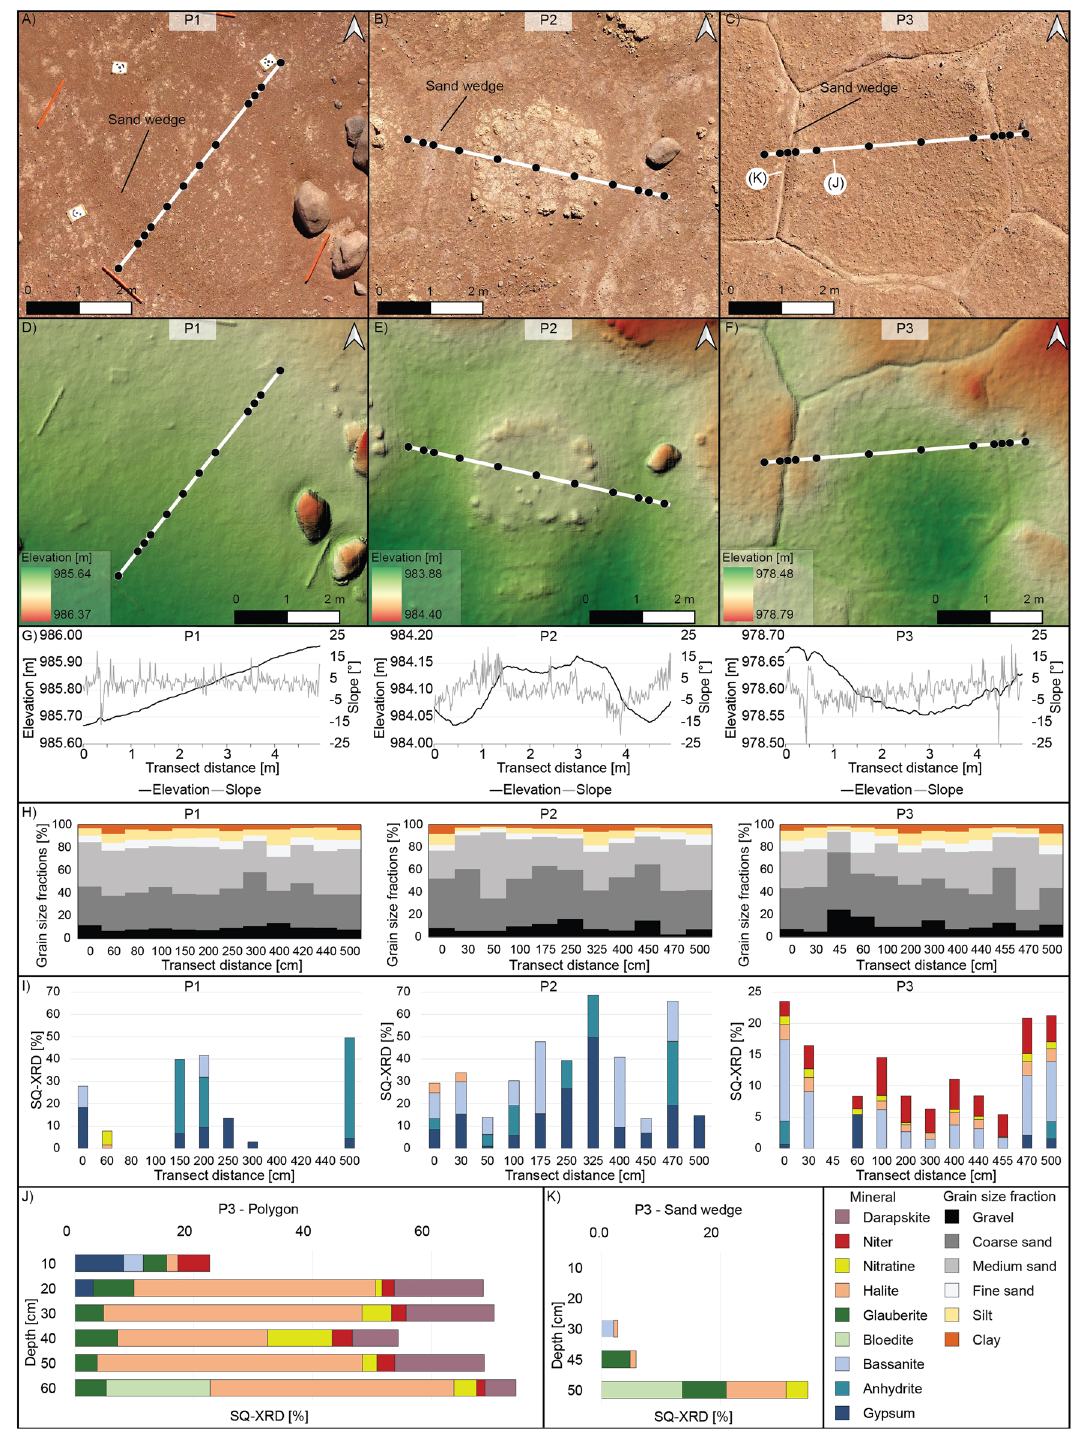
Figure 2. Morphological and geochemical data of the study site. ( A , B , C ) The polygons (P1, P2, P3) and sample locations (black dots) along the transect (white line) displayed as orthophotos, ( D , E , F ) digital elevation models, ( G ) polygons profiles, ( H ) grain size distribution and ( I ) salt composition based on semi-quantitative X-ray diffraction (SQ-XRD) along the soil transects and ( J , K ) two depth profiles for the polygon and the sand wedge at P3. Elevation is given in meter above sea level (m